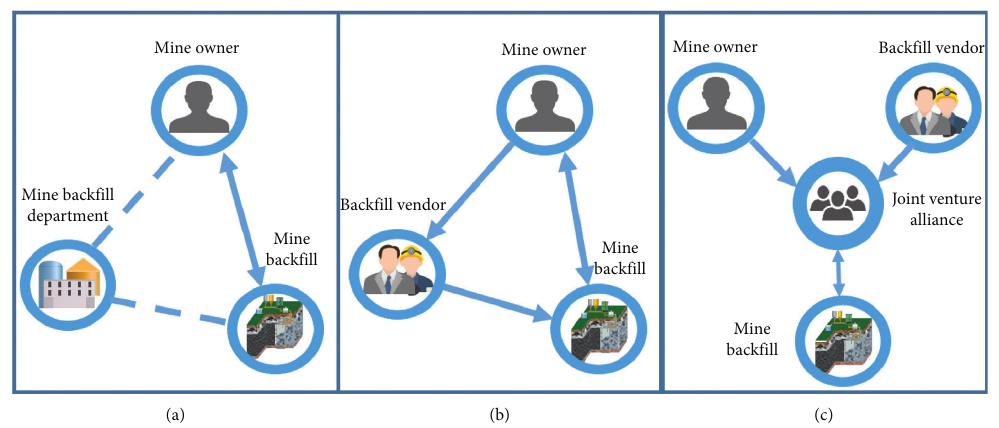
Figure 2: Schematic diagram of the proposed backfill operation